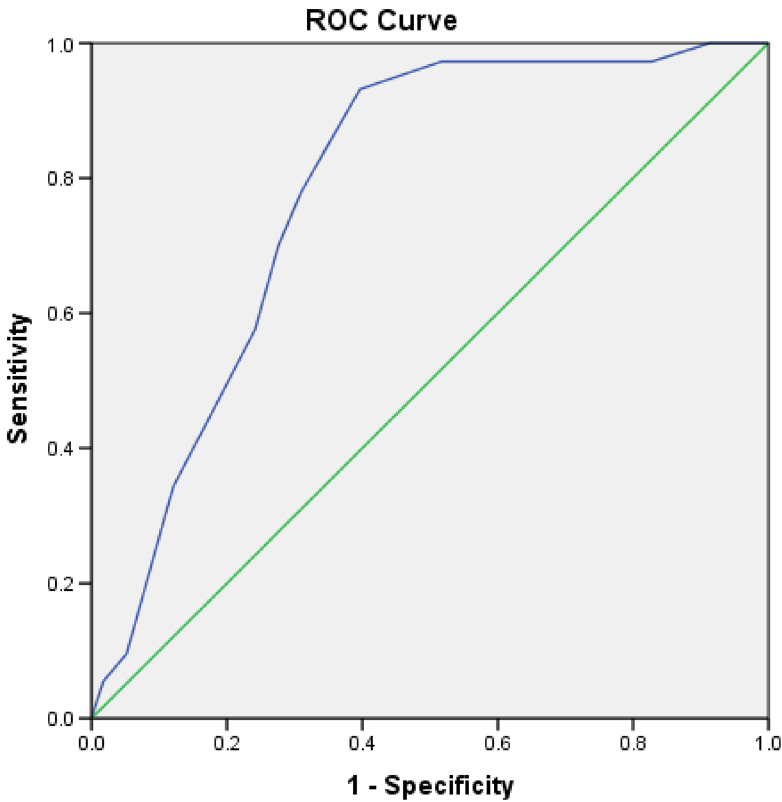
Figure 1. Receiver operating characteristic (ROC) curve for composite FMS score and MSI. The straight line showed the reference line, which was approximated by the ROC curve plotted on sensitivity (true positive rate) over 1-specificity (false positive rate) for each score total of the Functional Movement Screen (range, 0–21). Coordinates of the ROC curve showed that the composite FMS score corresponding best with the upper left hand portion of the curve was between 13.5 and 14.5 demonstrating the optimal cut-point score of 14 for the volleyball players participating in the